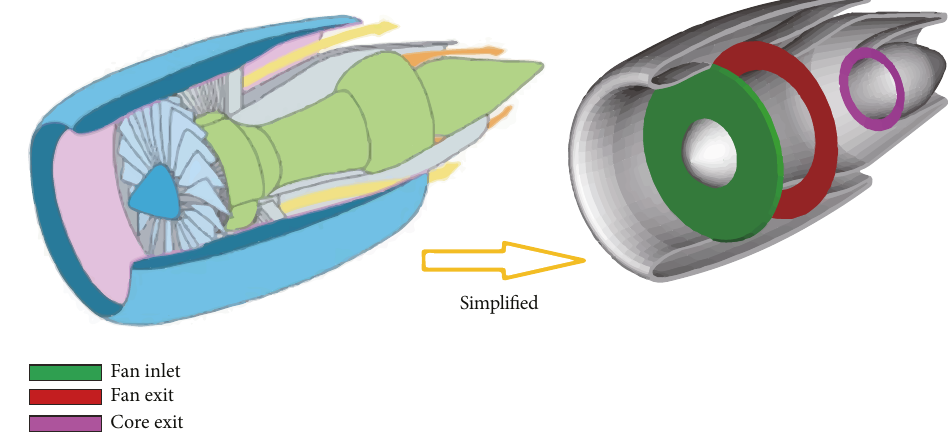
Figure 2: Engine model simpli fi cation.